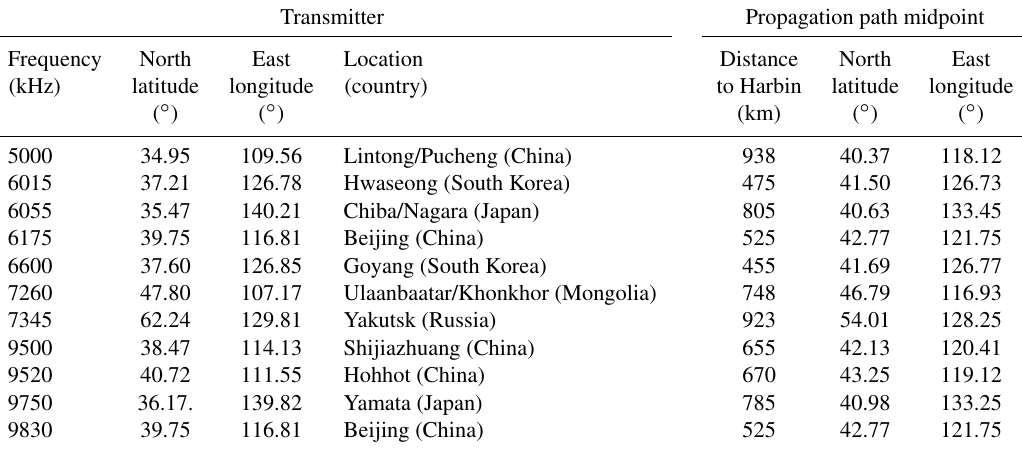
Table 1. Basic parameters of 11 radio paths used for probing the ionosphere at oblique incidence. Retrieved from https://fmscan.org/index.php (last access: 17 June